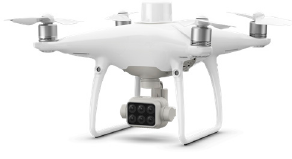
Figure 2. The DJI P4 Multispectral. Table 1. Flight height and flight date of three areas.